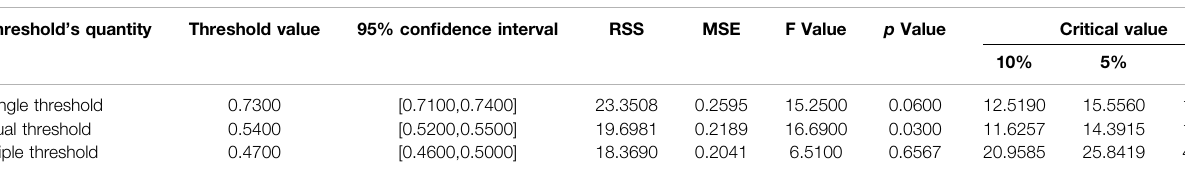
TABLE 8 | Threshold effect test.